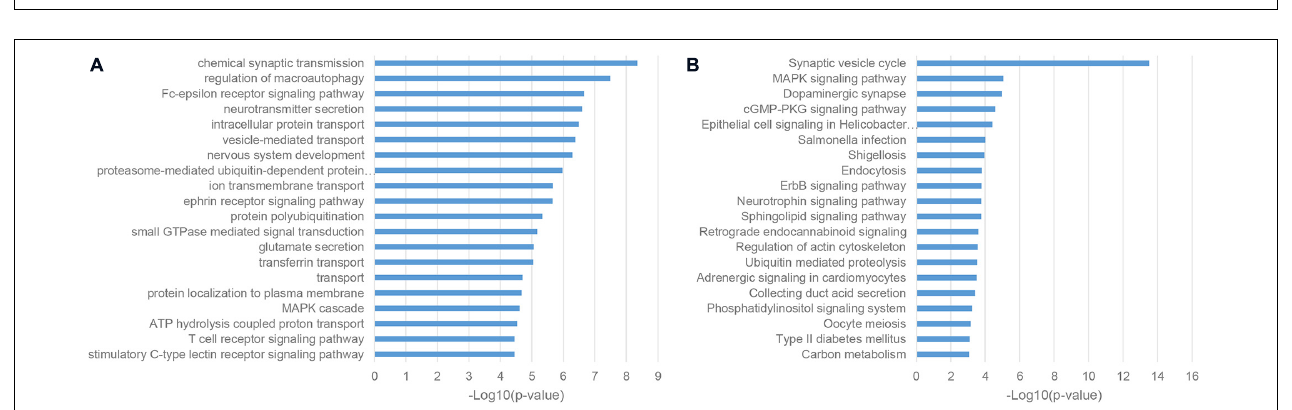
FIGURE 3 | Enriched functional terms of competing endogenous RNA (ceRNA) neighbors of ASD-related lncRNAs. (A) The top 20 GO BP terms with p -value < 0.05. (B) Top 20 KEGG pathway terms with p -value < 0.05.